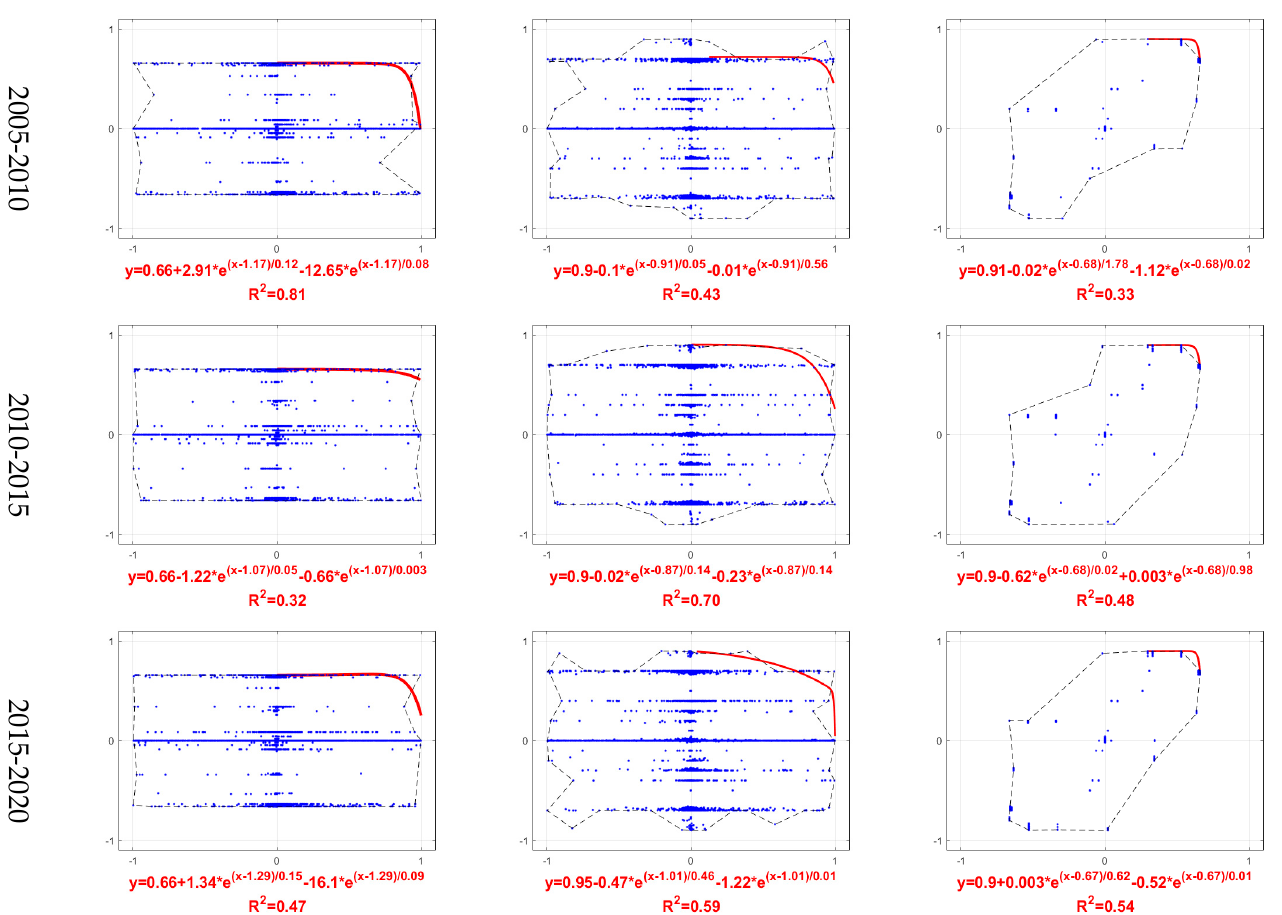
Figure 5 . Production possibility frontier curves for six pairs of ecosystem services in six periods. Remote Sens. 2022 , 14 , x FOR PEER REVIEW